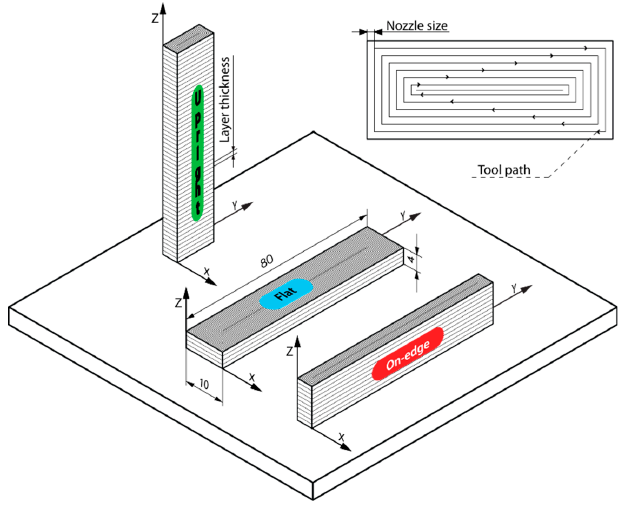
Figure 1. Detail of workpiece geometry and build orientations (on-edge, flat, and